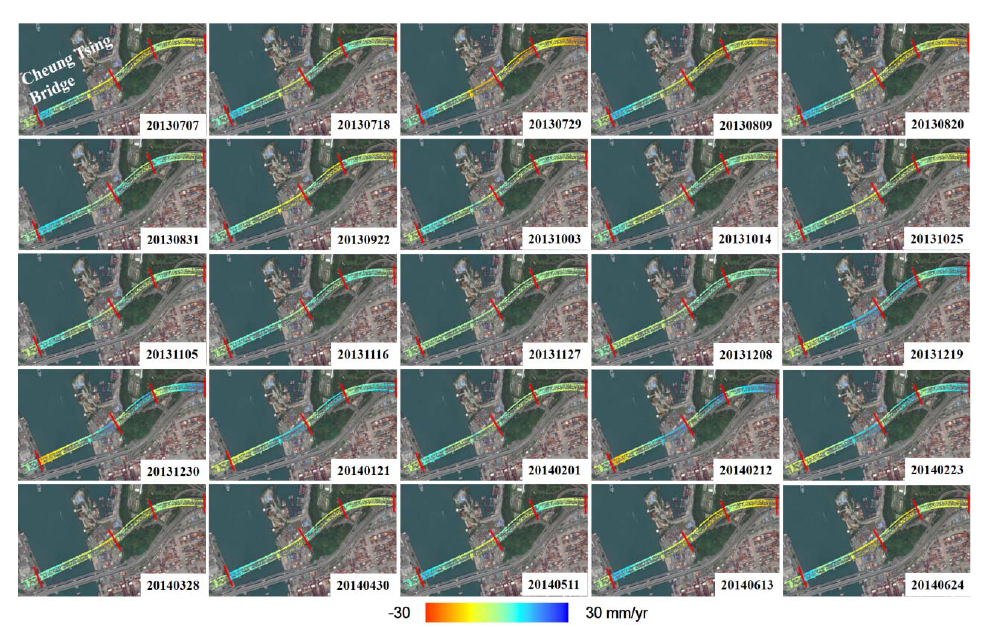
Figure 15. The time series longitudinal displacements of the TKH.